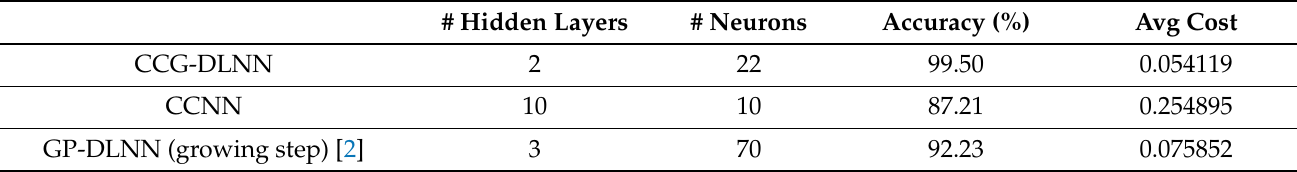
Table 2. Simulation results of CCG-DLNN, CCNN and GP-DLNN on the two-spiral